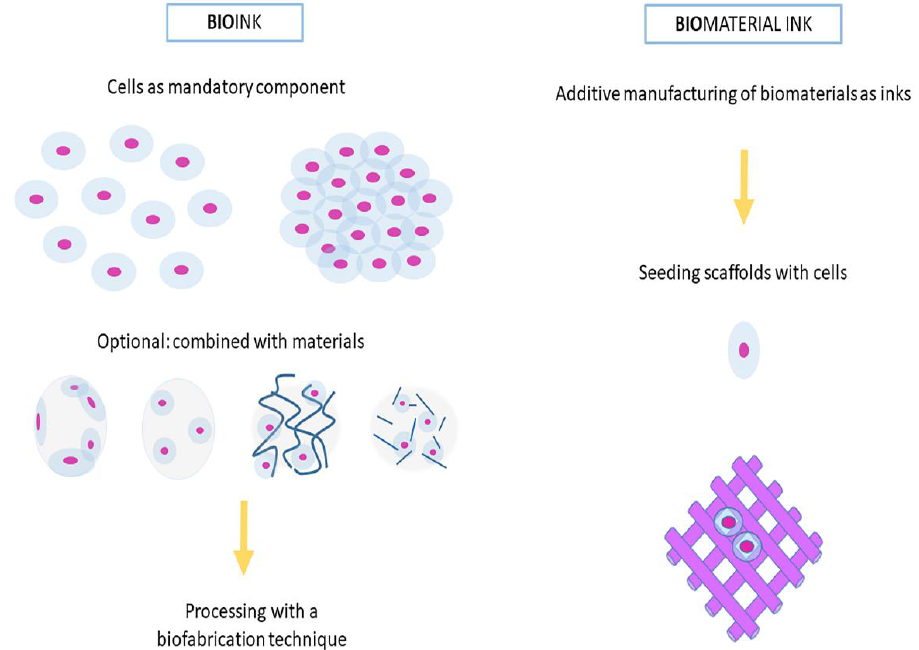
Figure 3. Distinction between a bioink ( left ), where cells are a mandatory component of the printing formulation as single cells, coated cells and cell aggregates (of one or several cell types), or in com- bination with materials (for example seeded or formulated in a physical hydrogel) and a biomaterial ink ( right ), where a biomaterial is used for printing and cell-contact takes place post-fabrication.